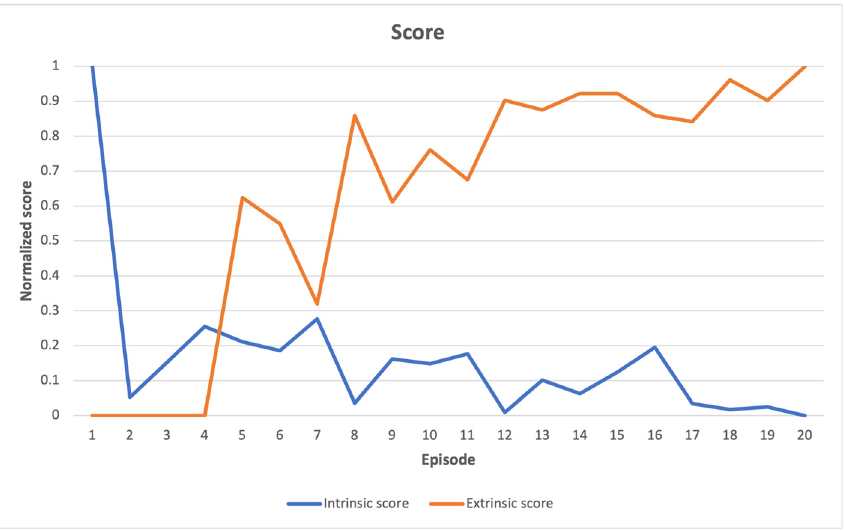
Figure 2. Acrobot-v1 learning scores indicate a relatively steady enhancement in the extrinsic score as the task is completed, which is accompanied by a reduction in novelty exploration. This implies a gradual fi ne-tuning of parameters.